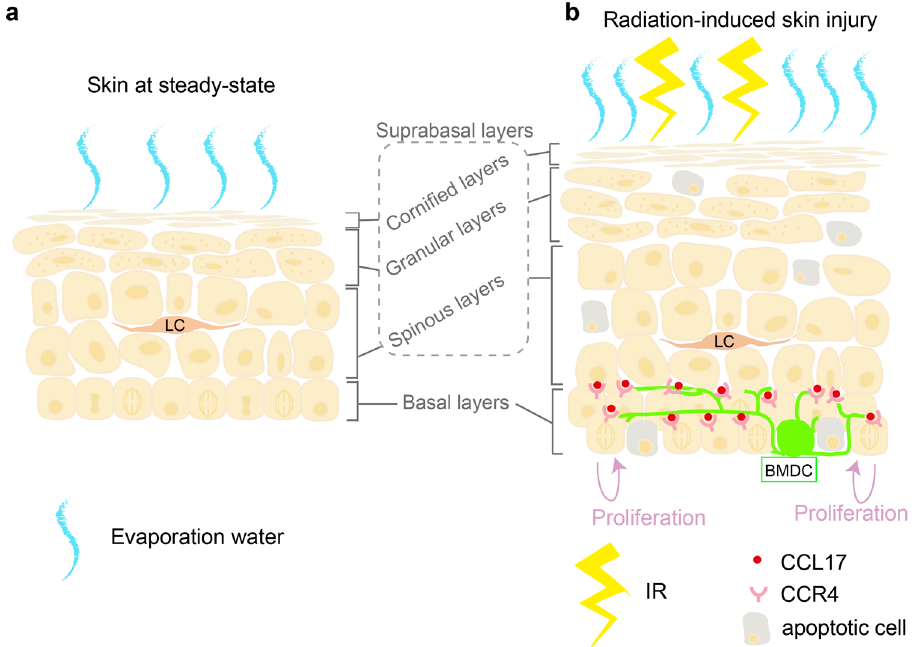
Figure 6. Summary of the study. ( a ) The skin at steady state. ( b ) In response to IR, BMDCs migrate to the injured skin. CCL17 secreted by BMDCs binds to CCR4, which is induced in epidermal cells to stimulate cell proliferation and recover from radiation-induced skin injury. As a result, the epidermis becomes thicker than that at the steady state. IR, ionising radiation; BMDCs, bone marrow-derived cells; LC; Langerhans